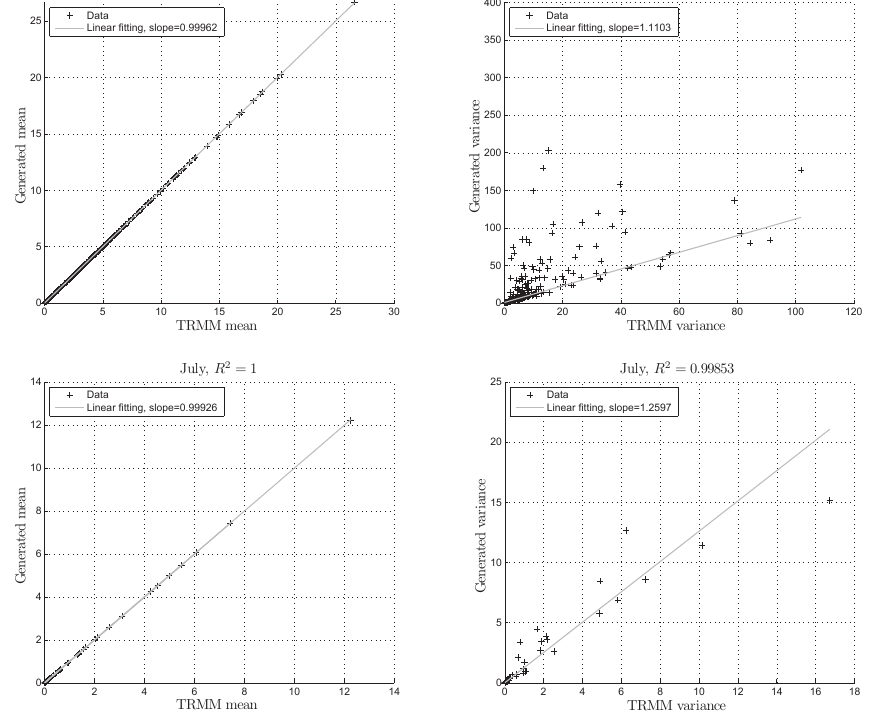
Figure 10. Comparison between TRMM and simulated rainfall means from 1999 to 2006 in the months of February and